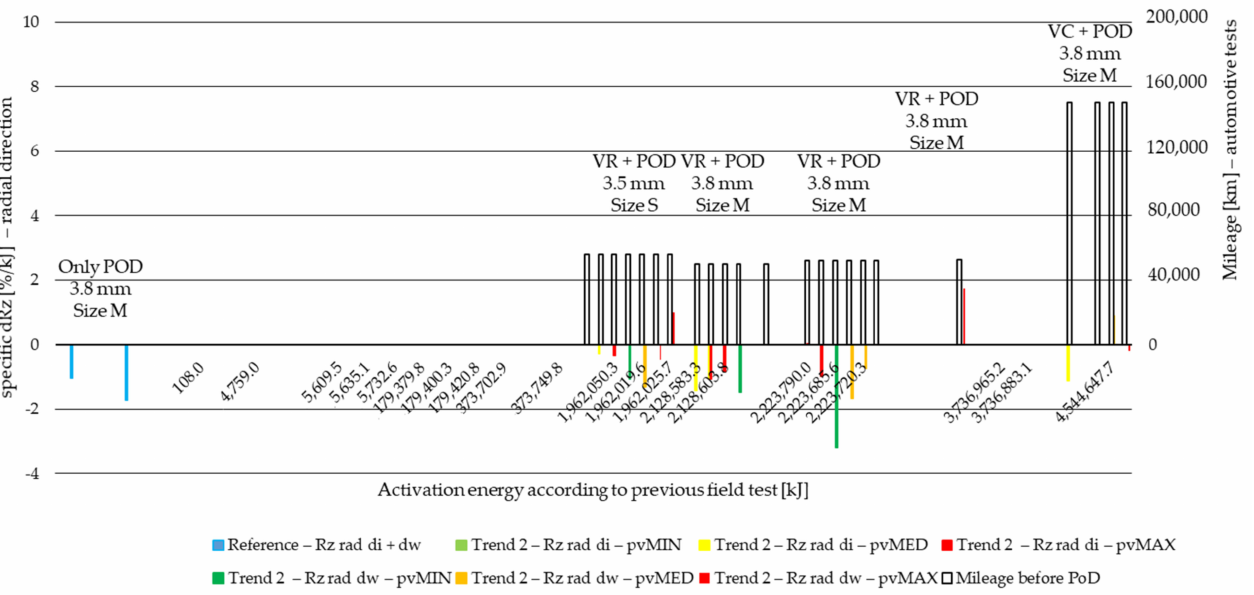
Figure A3. Radial direction PoD specific Rz difference values of cut material samples from inner and working diameter after minimum, medium and maximum pv level pin-on-disc tests with previous field-test (Table 2) mileage along Joule scale—Trend 2: moderate load